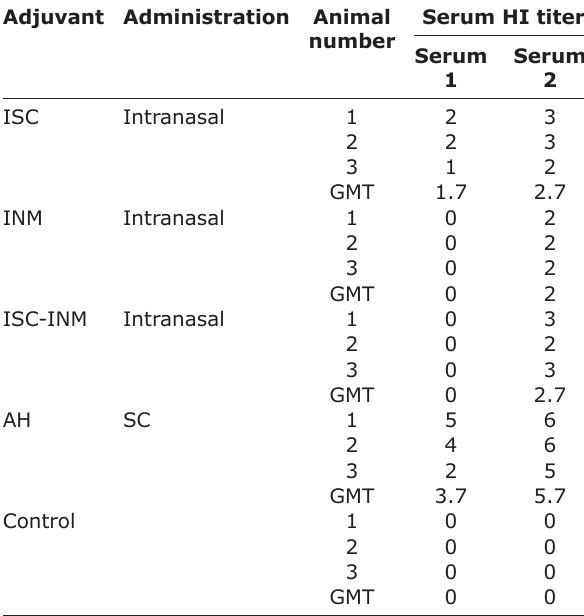
Table-1: GMT (−log 2 HI) of anti‑AIV‑H5 antibody in the serum of chicken following vaccination with inactivated AIV vaccine with various adjuvants through intranasal administration and subcutaneous injection.